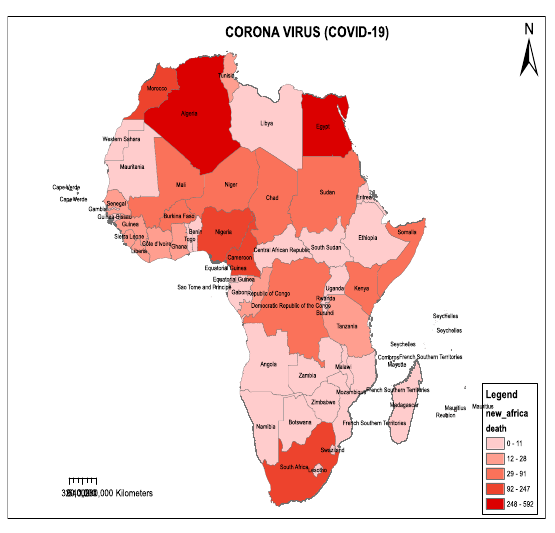
Fig. 13. Drivers of COVID-19 mortality in Africa.